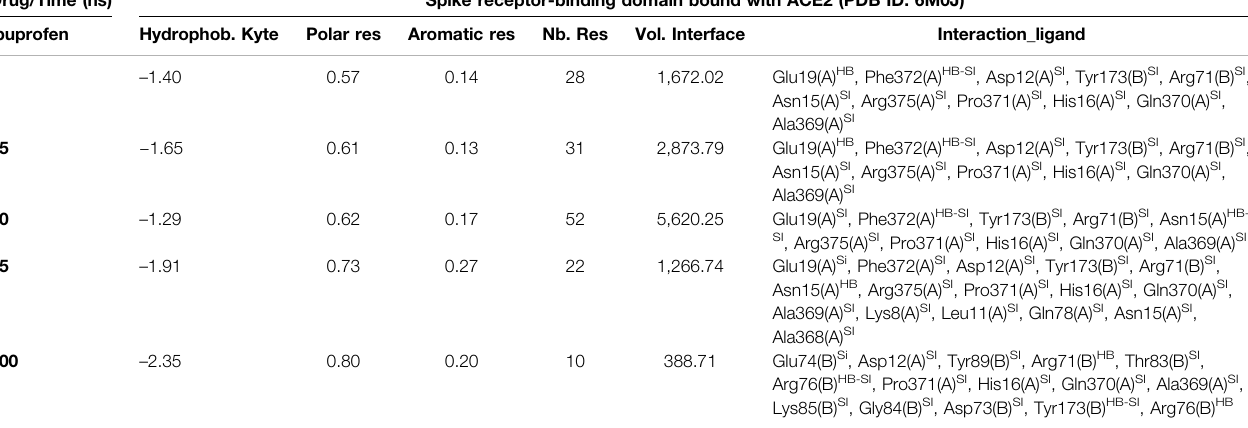
TABLE 5 | Biophysical characteristics associated with the amino acid composition of the Ibuprofen binding pocket at the RBD-ACE2 interface and as a function of simulation time. Drug/Time (ns) Spike receptor-binding domain bound with ACE2 (PDB ID: